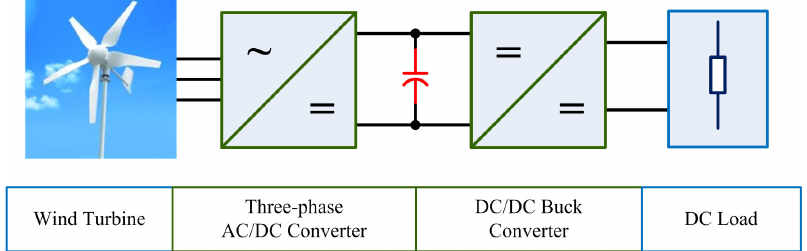
Figure 1. Block diagram of the off-grid wind generation